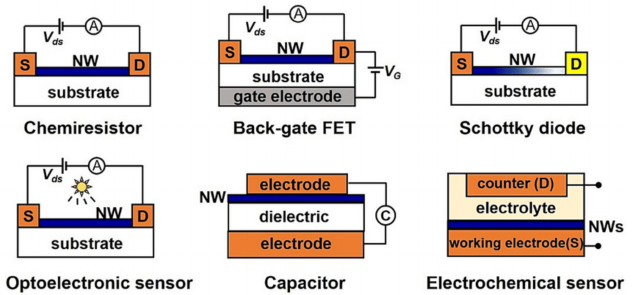
Figure 4. Schematic illustration of electrically transduced gas sensors [31].